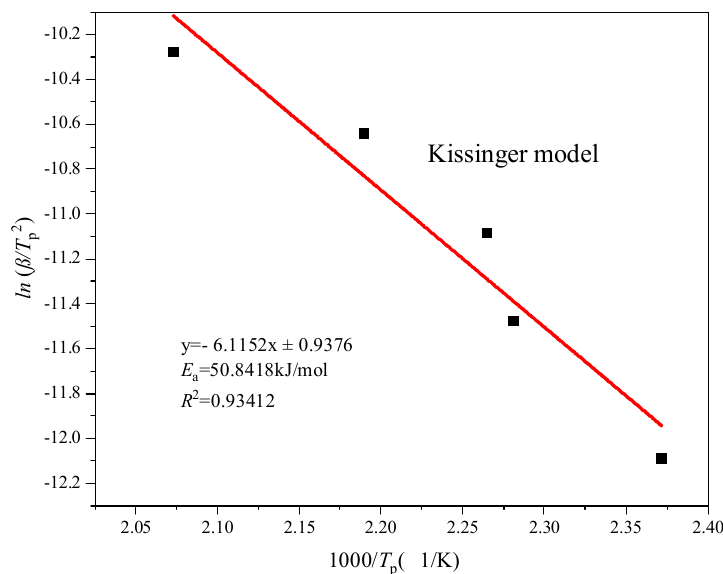
Figure 7. Kissinger model at different β in DSC experiments for PSS + (NH 4 ) 2 SO 4 .